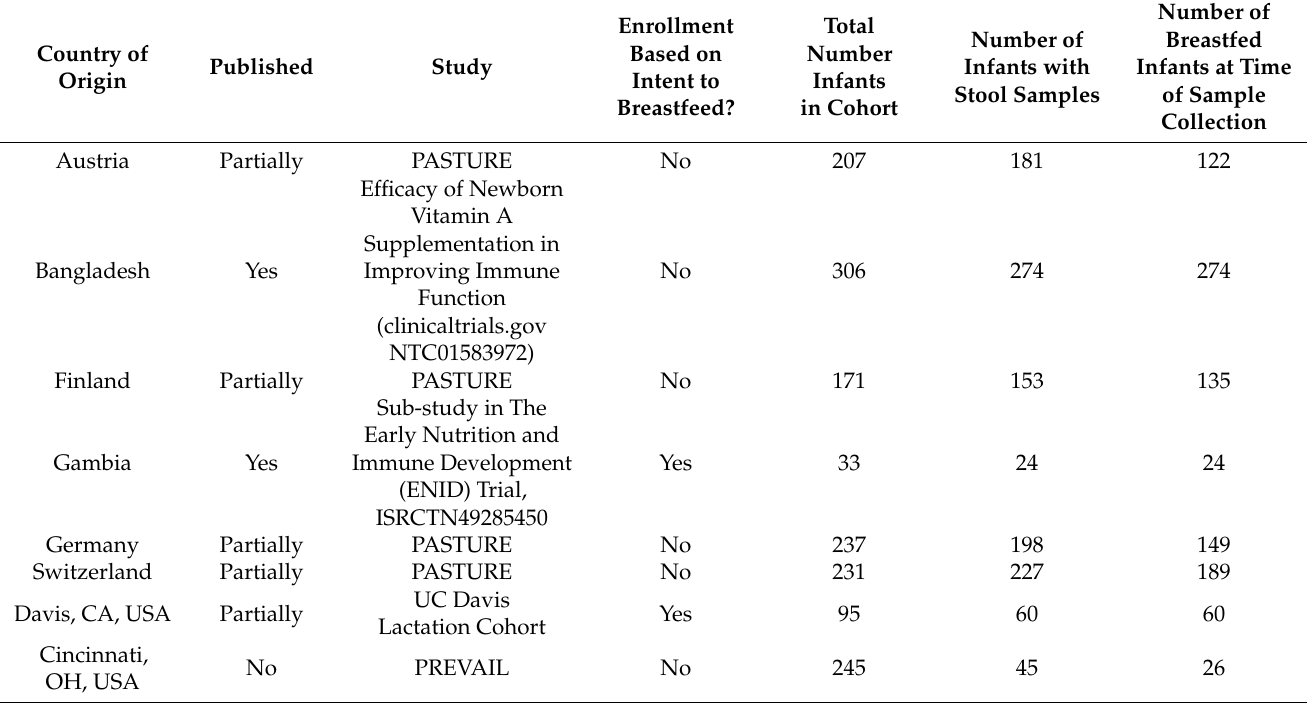
Table 1. Source of included cohorts, and number of infants included in the present study from each